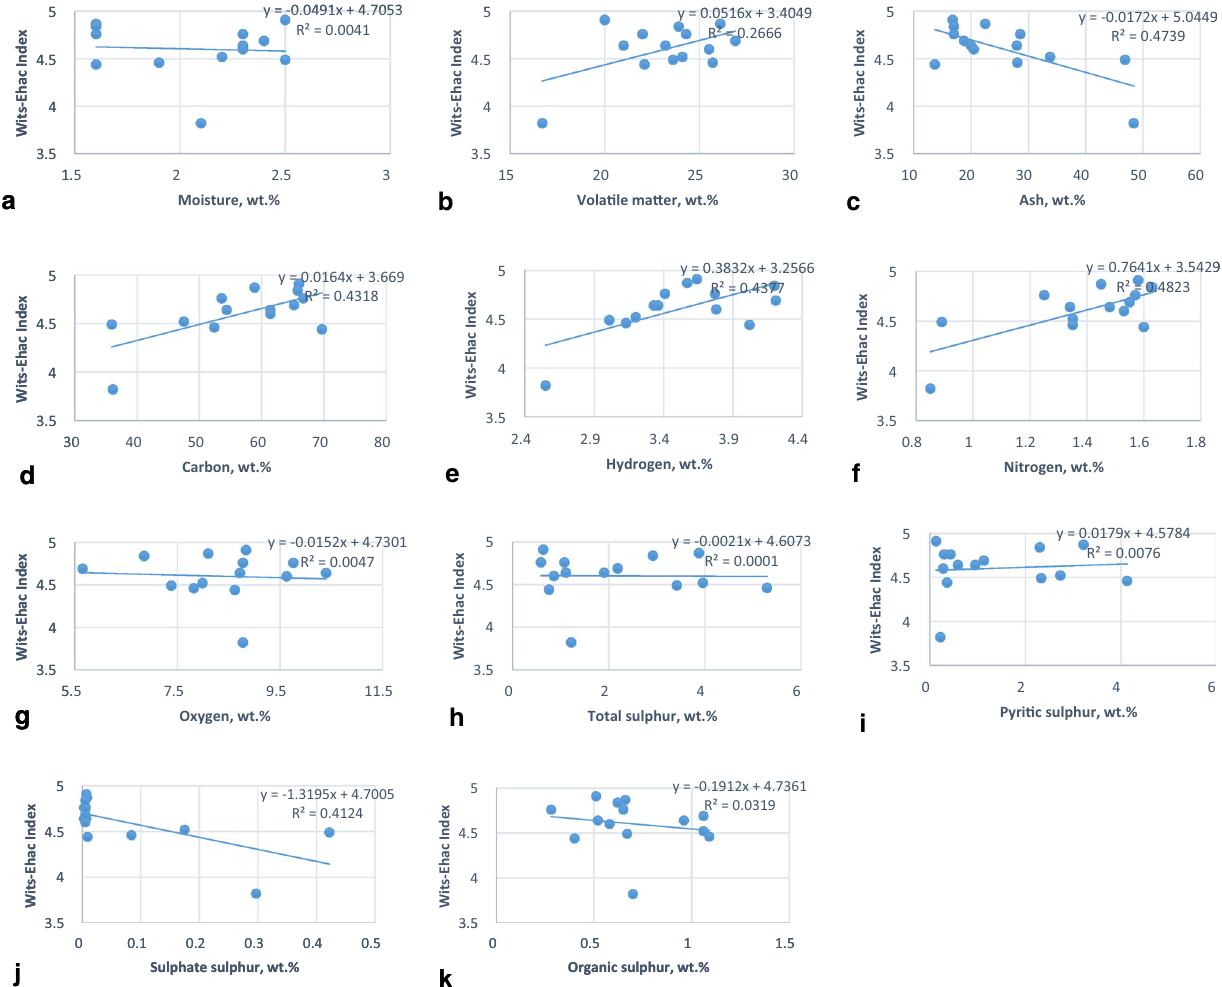
Fig. 3 Influence of proximate and ultimate analysis on spontaneous combustion liability of